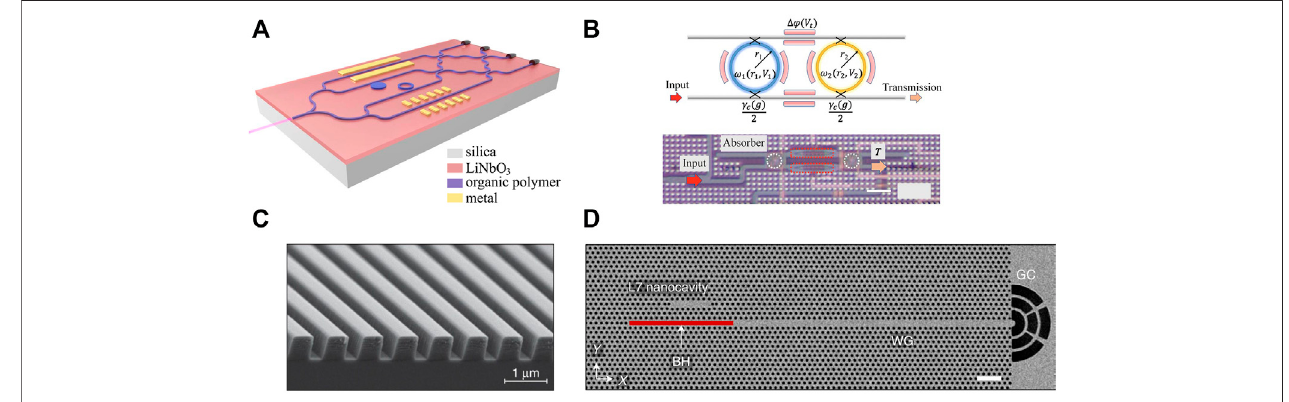
FIGURE9| BIC-basedphotonicintegratedcomponents,including (A) photoniccircuitwherelow-refractiveindexmaterialwaspatternedonahigh-refractive-index substrate. Adapted with permission from [178] copyright The Optical Society, (B) fi lter [179], copyright American Physical Society. (C) Grating coupler [43], copyright Springer Nature Ltd. and (D) laser [180], copyright Springer Nature